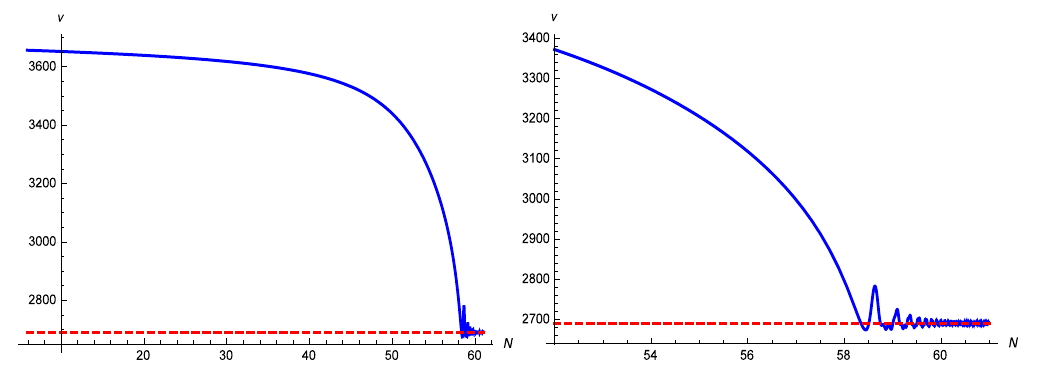
Figure 7 . Evolution of as a function of the number of efoldings N for (left) the entire inflationary V dynamics and (right) for the last 6 efoldings. The dashed red line represents the position of the final global minimum.